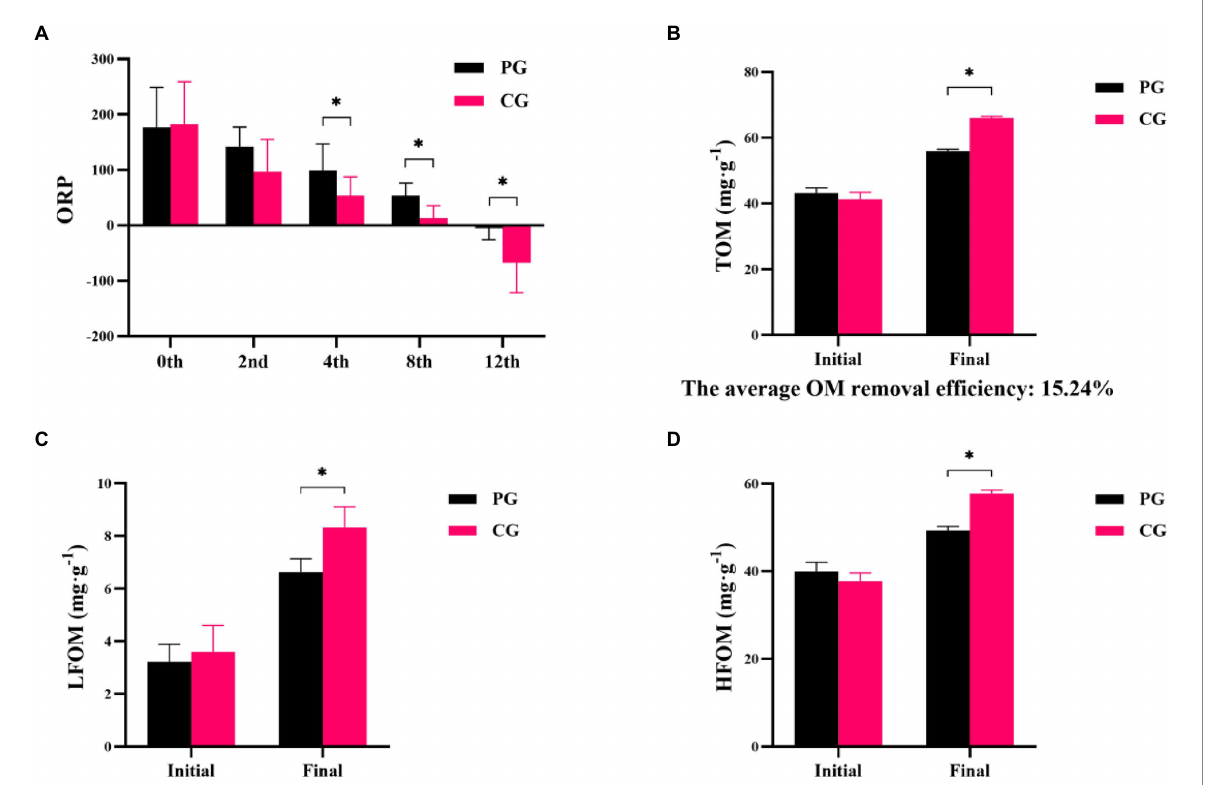
FIGURE 1 Differences in sediment characteristics between PG and CG groups during the experimental period, including oxidation–reduction potential (ORP; A ), total organic matter (TOM; B ), light fraction organic matter (LFOM; C ), and heavy fraction organic matter (HFOM; D ). “Initial” and “Final” indicate the initial and final stages of the experimental period, respectively. 0th, 2nd, 4th, 8th, and 12th indicate the initial stage, 2nd, 4th, 8th, and 12th week, respectively. * indicates a significant difference between PG and CG groups ( p <